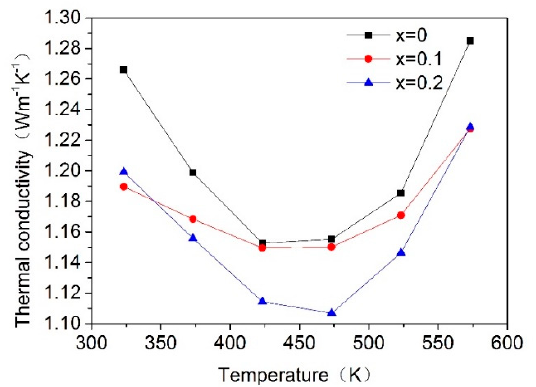
Figure 7. The thermal conductivity of Sm:LGN crystals.